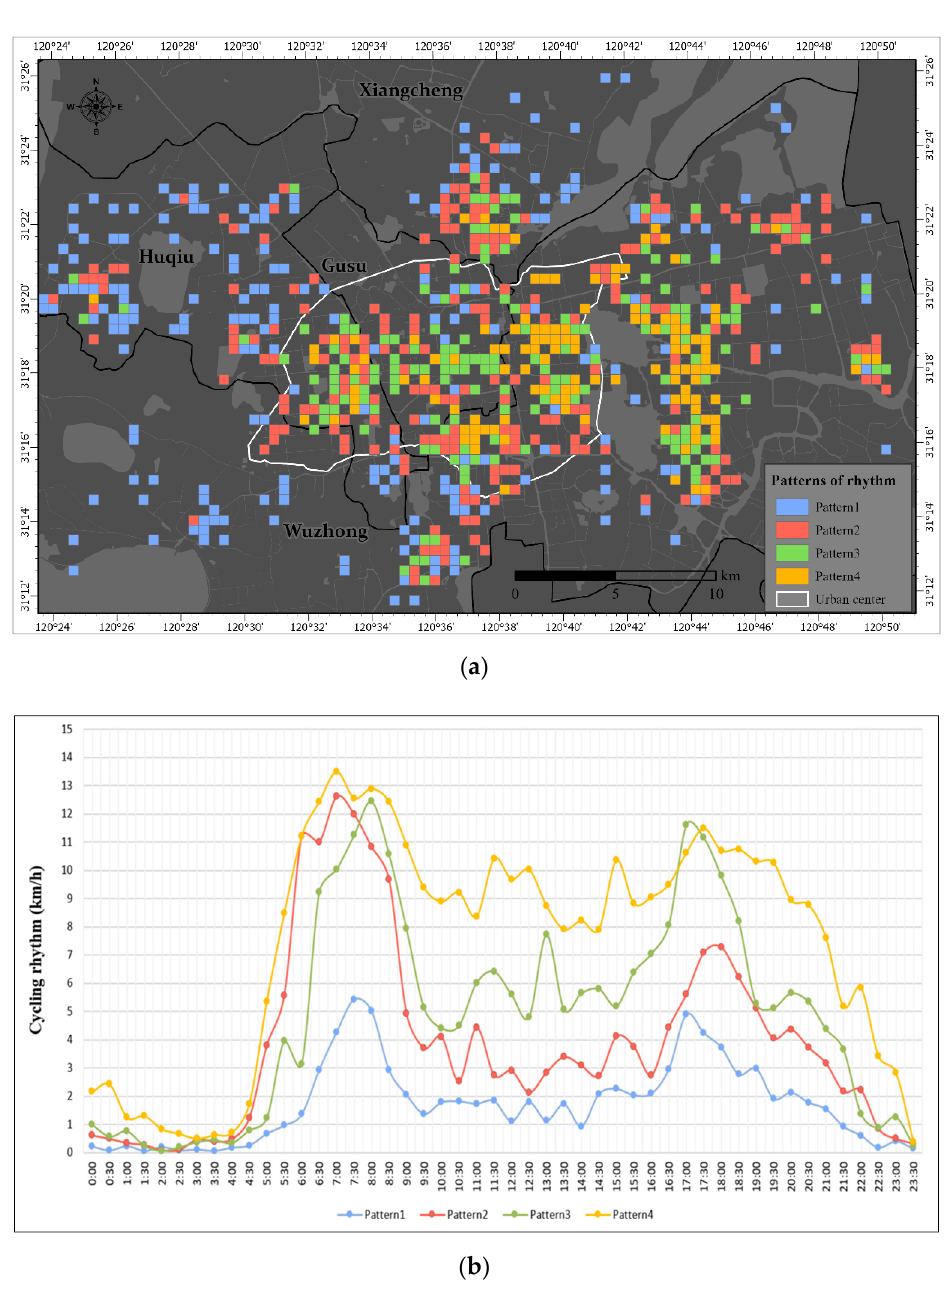
Figure 10. Spatiotemporal patterns of cycling rhythm. ( a ) distribution of cycling rhythm patterns in urban area; ( b ) ultrafine modes of cycling rhythms.